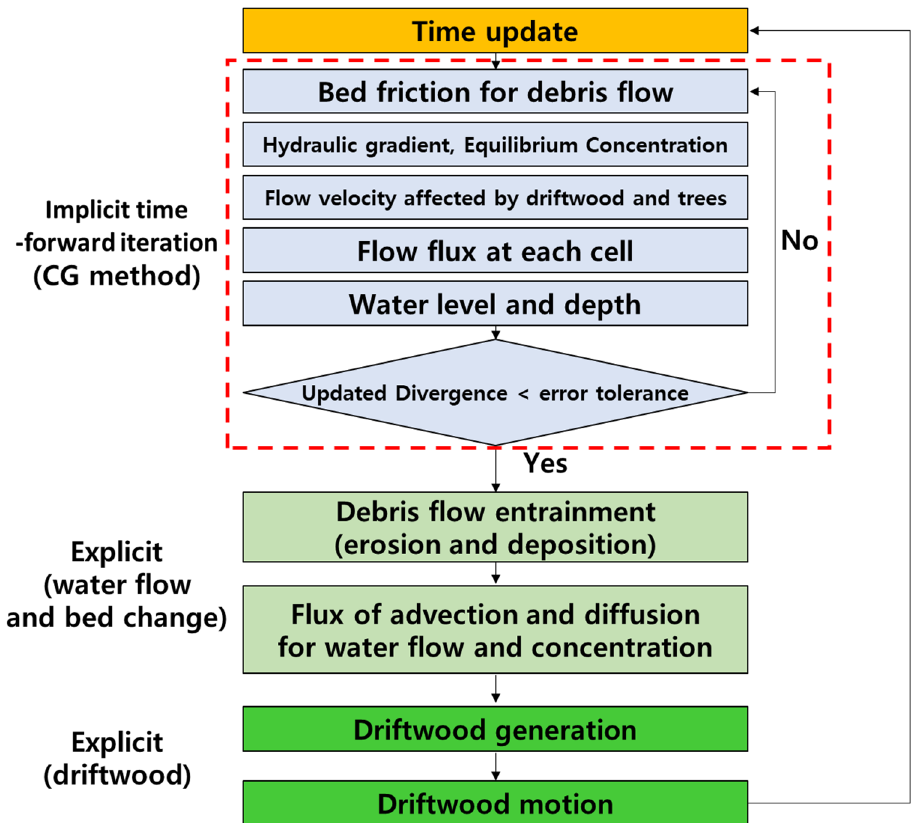
Figure 3. Flow chart of calculation procedure. Table 1. Parameters of computational model and simulation